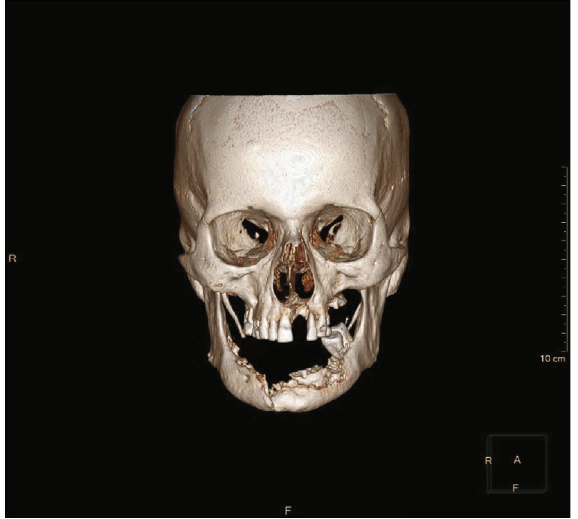
Figure 3: Preop CT scan showing right parasymphysis and dentoalveolar factures.